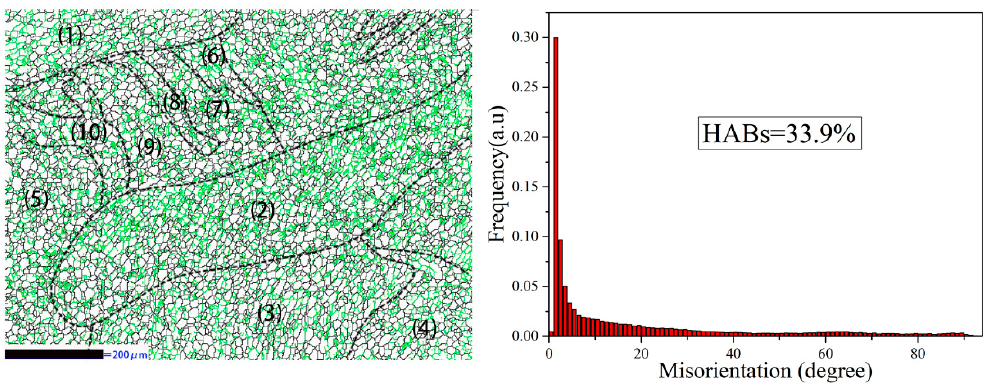
Figure 6. Distribution of grain boundary misorientation in the Ti6242S billet; green lines represent the low angle boundaries (LABs) (0–15°) but the high angle boundaries (HABs) (>15°) were indicated by black lines. The right map shows the statistical distribution of misorientation among grain boundaries.